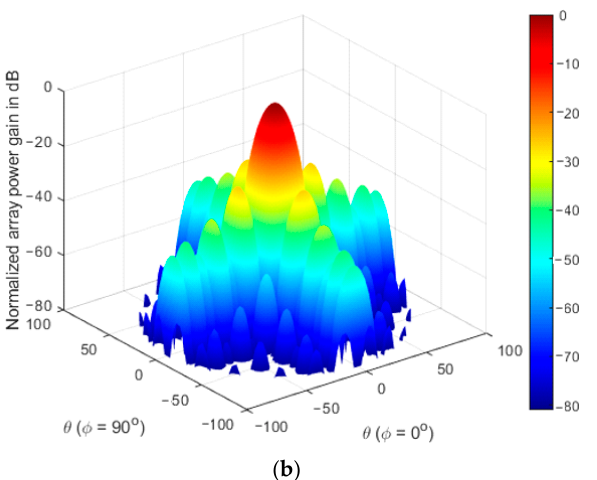
Figure 4. ( a ) 2D cross-linear extrapolated triangular window for 16 × 16 array. ( b ) Normalized array power pattern.